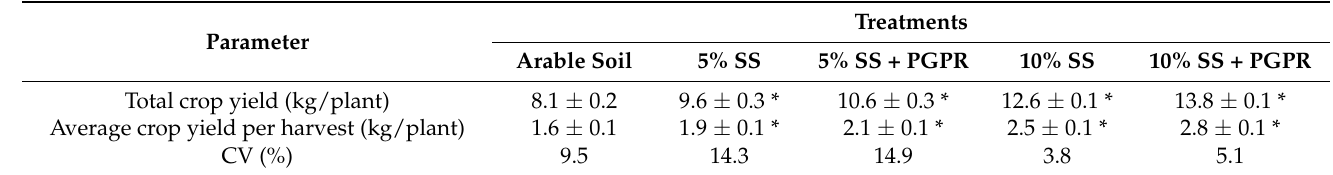
Table 4. Crop yield (mean ± standard deviation, n = 3) of Ridge gourd ( L. acutangula ) cultivation under different sewage sludge (SS) and plant growth-promoting rhizobia (PGPR) treatments.